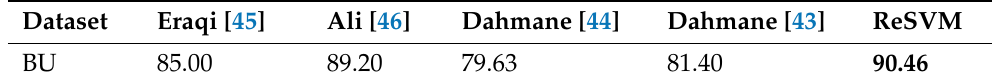
Table 8. Comparison using BU dataset.